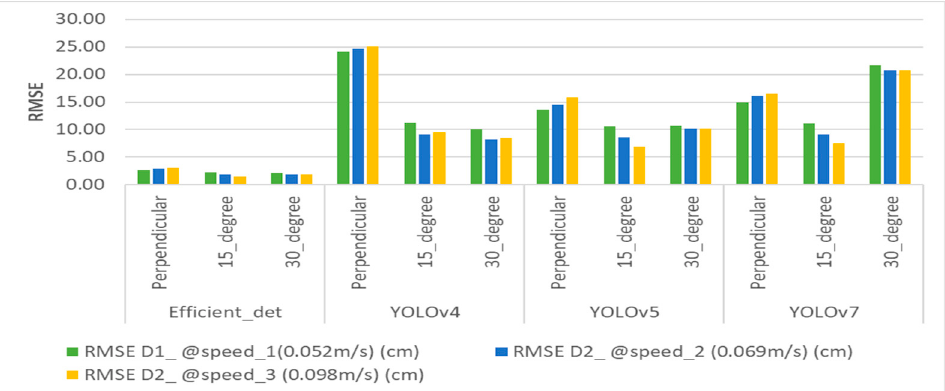
Figure 19. Summary of RMSE values for different orientation angles and deep learning algorithms.